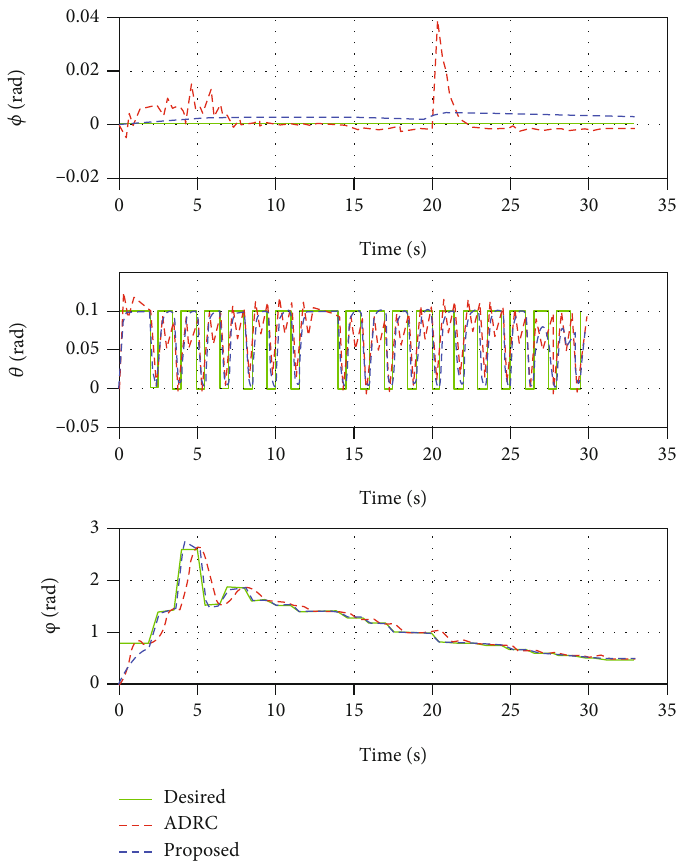
Figure 16: Tracking results for reference